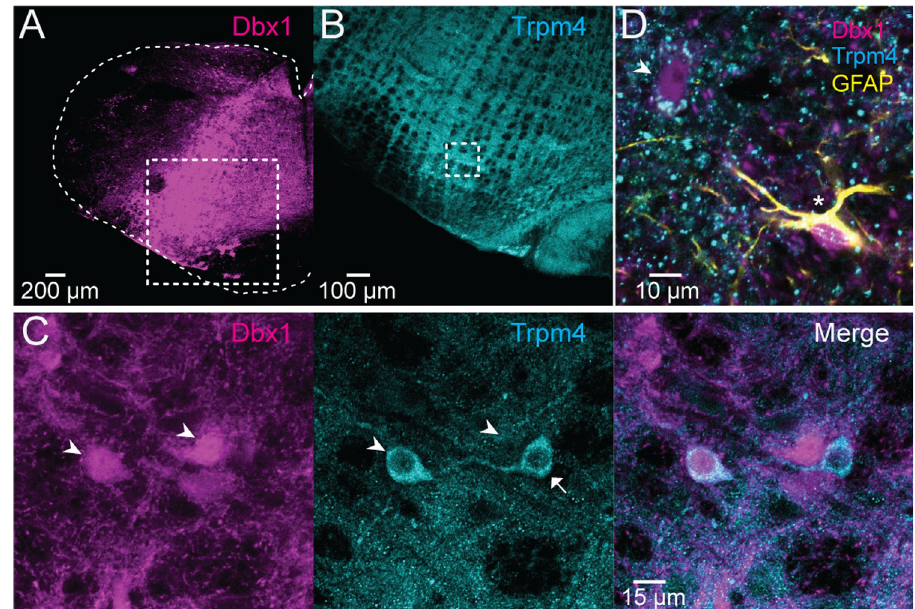
Fig 2. Trpm4 ion channels in preBo¨tC neurons. (A) Transverse section from an adult Dbx1;Ai9 mouse showing tdTomato (magenta) expression in Dbx1-derived cells. (B) Selection box from A encompasses the preBo¨tC and shows Trpm4 expression (cyan). (C) Selection box from the preBo¨tC in B showing tdTomato (Dbx1) and Trpm4 expression in preBo¨tC neurons. Trpm4 is expressed in both Dbx1 neurons (arrowheads) and non-Dbx1 neurons (arrow). (D) GFAP expression (yellow) identifies Dbx1-derived astrocytes of the preBo¨tC (yellow and magenta, marked with an asterisk), which lack Trpm4 expression. Arrowhead identifies a Dbx1 neuron with Trpm4 expression. Separate scale bars are shown for A, B, C, and D. Dbx1, developing brain homeobox 1; GFAP, glial fibrillary acidic protein; preBo¨tC, pre-Bo¨tzinger complex; Trp, transient receptor